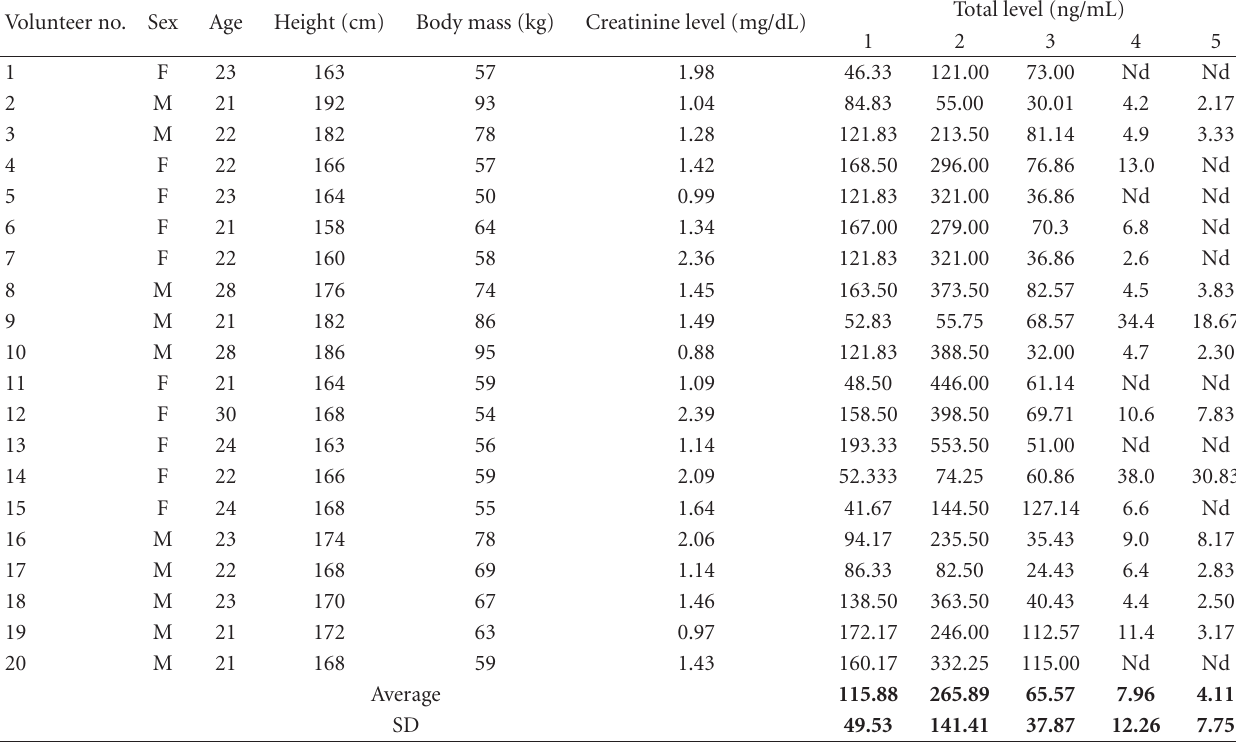
Table 3: Results of the urinary total steroid levels in healthy